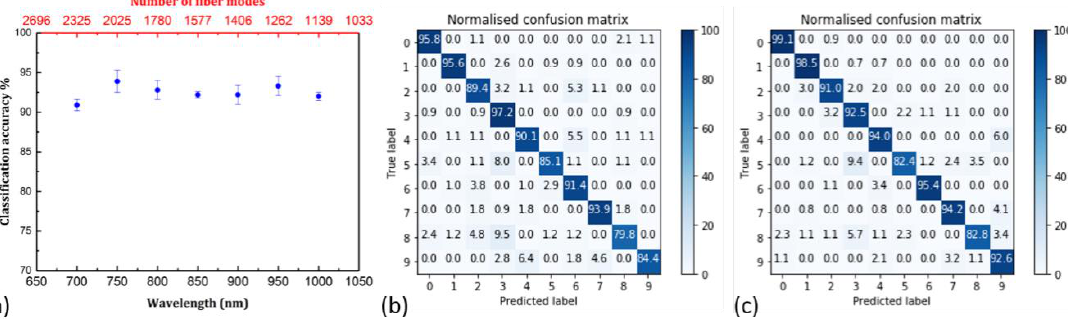
Figure 4. ( a ) Classification accuracy as a function of wavelength and number of fiber spatial modes for the wavelength range of the tunable laser source; Normalized confusion matrix for the datasets collected at the ( b ) 700 nm; and ( c ) 1000 nm wavelength.